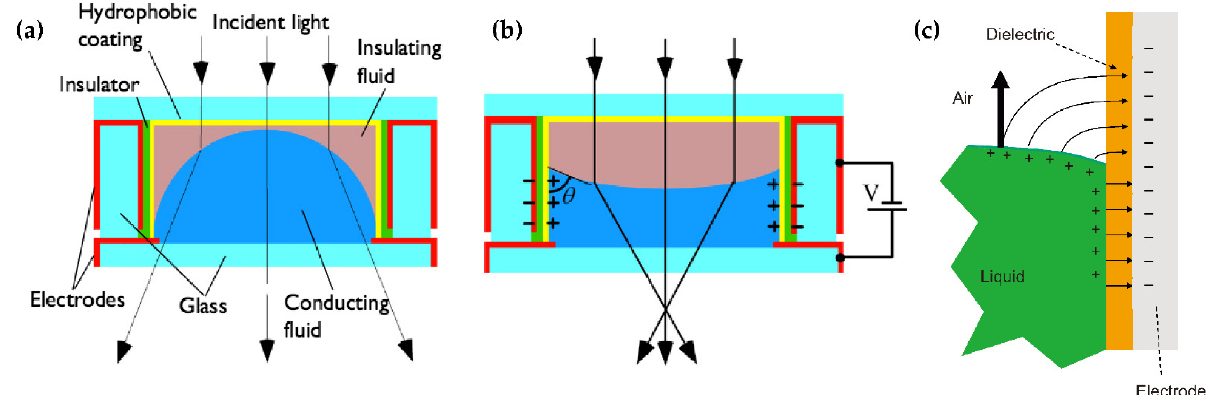
Figure 2. Electrical control diagrams of ( a ) electrowetting when the voltage is off ( b ) and the voltage is on [40]. ( c ) The diagrams of dielectrophoresis [41]. Reprinted with permission from Refs. [40,41]. 2004 AIP Publishing and 2013 Elsevier Science.